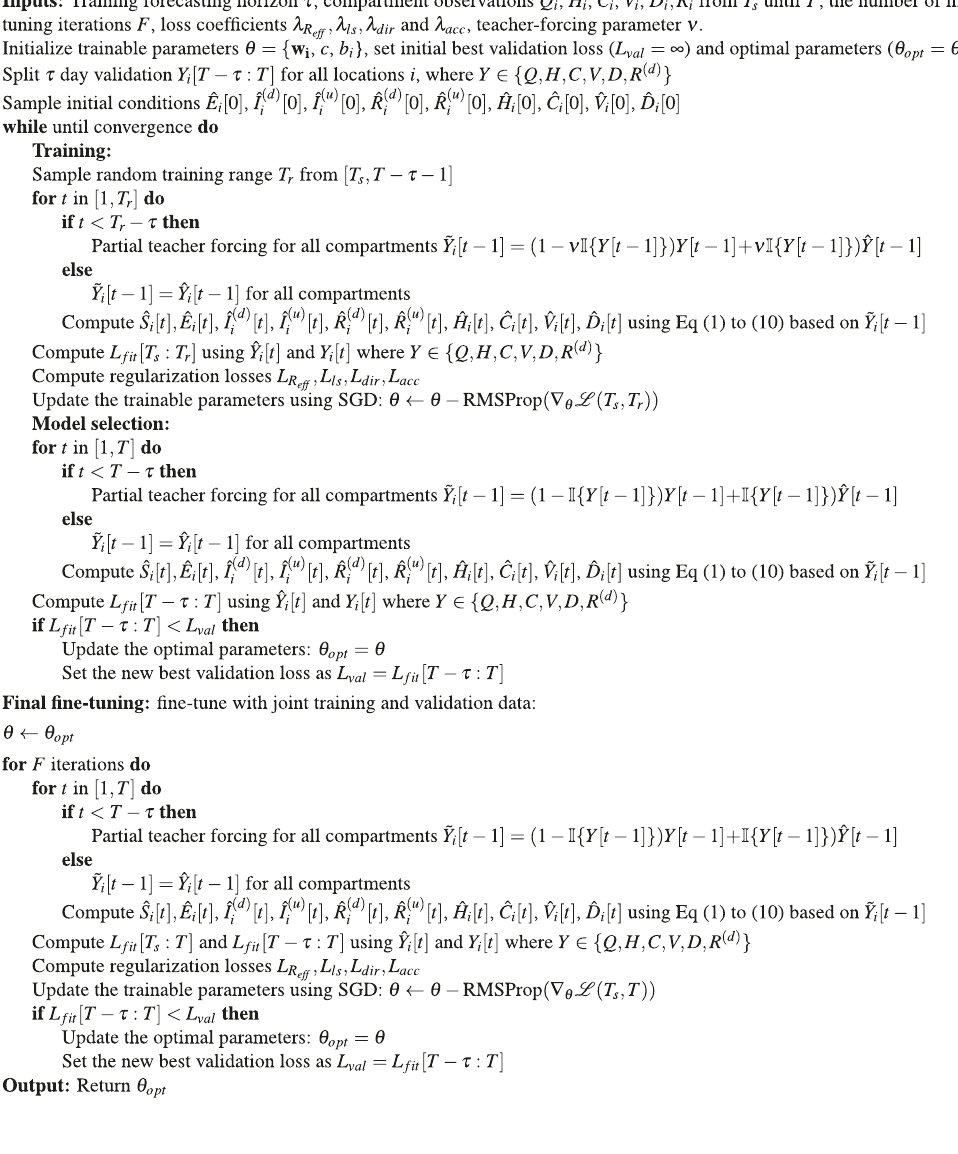
Algorithm 1 Detailed pseudocode for model